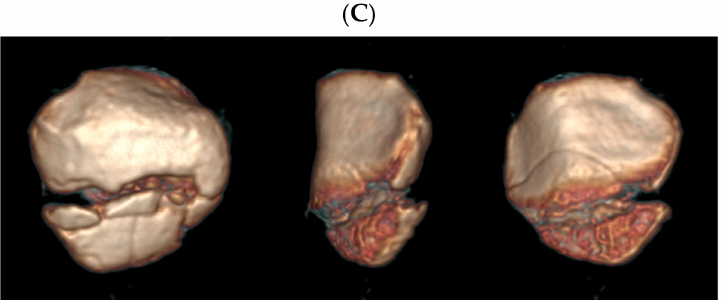
Figure 3. Plain radiographs ( A ), two-dimensional computed tomography ( B ), and three-dimensional computed tomography ( C ) of a patellar inferior pole fracture. In addition to the displaced extra-articular fracture, non-displaced linear articular fracture lines exist. The respondents chose either type A or C.